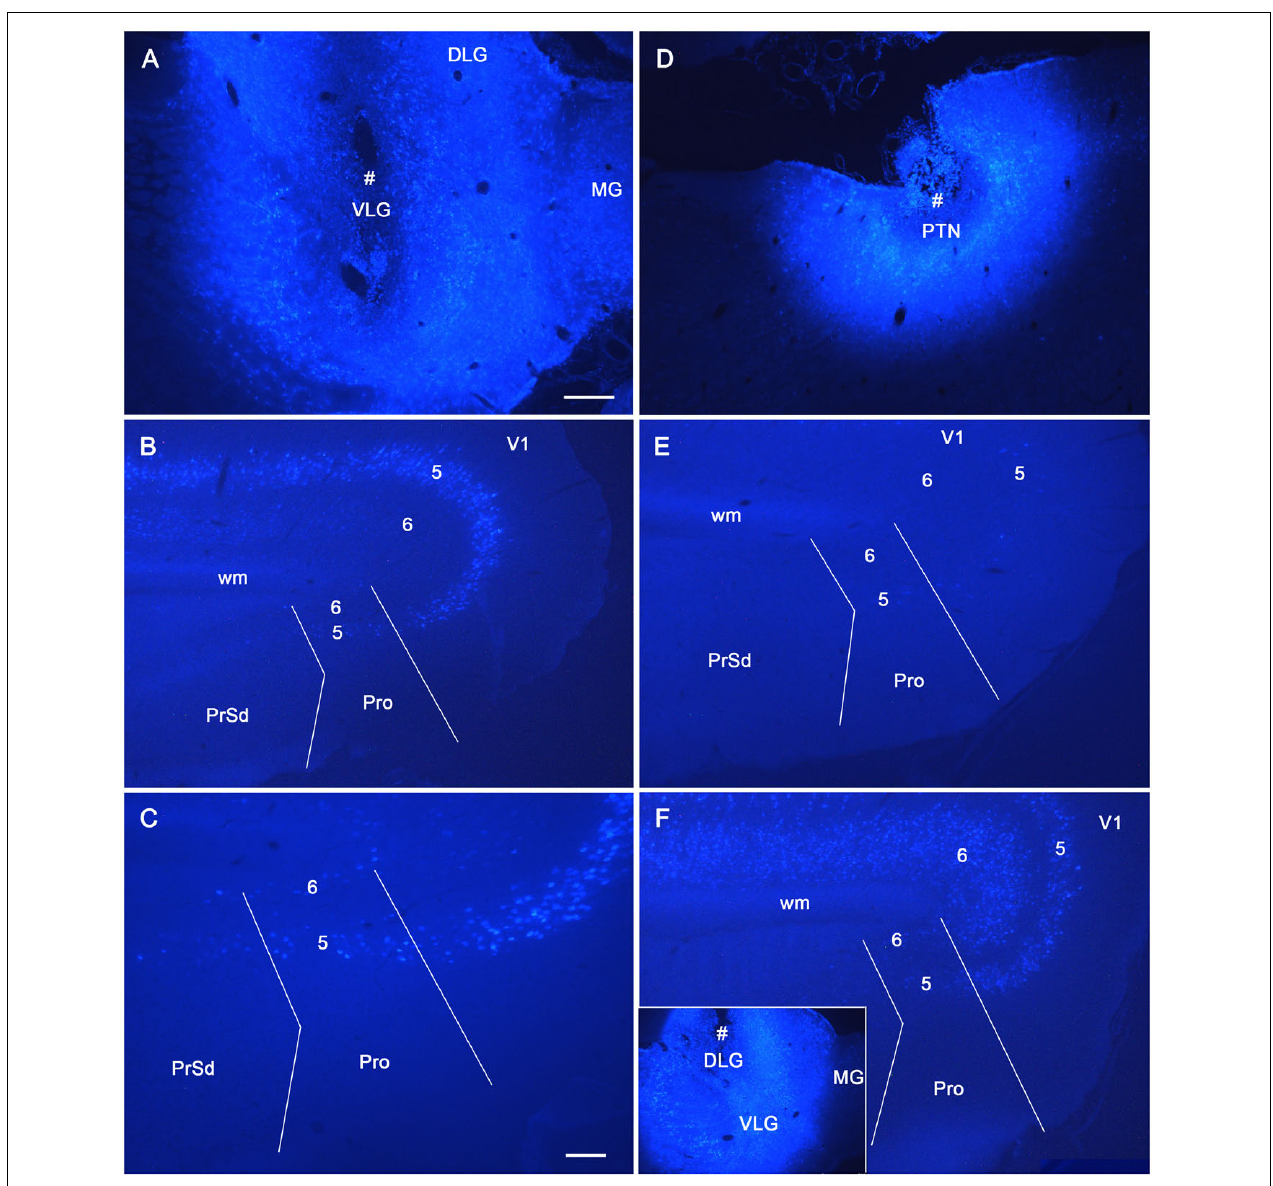
FIGURE 7 | The origins of cells projecting from rat prostriata to VLG and PTN. All panels are from sagittal sections. (A–C) The Fluoro-Gold (FG) injection in the VLG (# in A ) results in retrogradely labeled cells mainly in layer 5 of V1 and prostriata ( B , with higher power view in C ). Some labeled neurons are also found in layer 6 of the prostriata (C) . (D,E) Another FG injection in pretectal nucleus (PTN, # in D ) results in some retrogradely labeled cells in layer 5 of V1 and prostriata (E) . (F) As a comparison, one FG injection located mostly in the DLG (# in the inset) produces many labeled neurons in layers 5–6 of V1 with much fewer in the prostriata. Note that the injection is only slightly involved in VLG. Bars: 250 µ m (A) for (A,B,D–F) ; 100 µ m (C) .